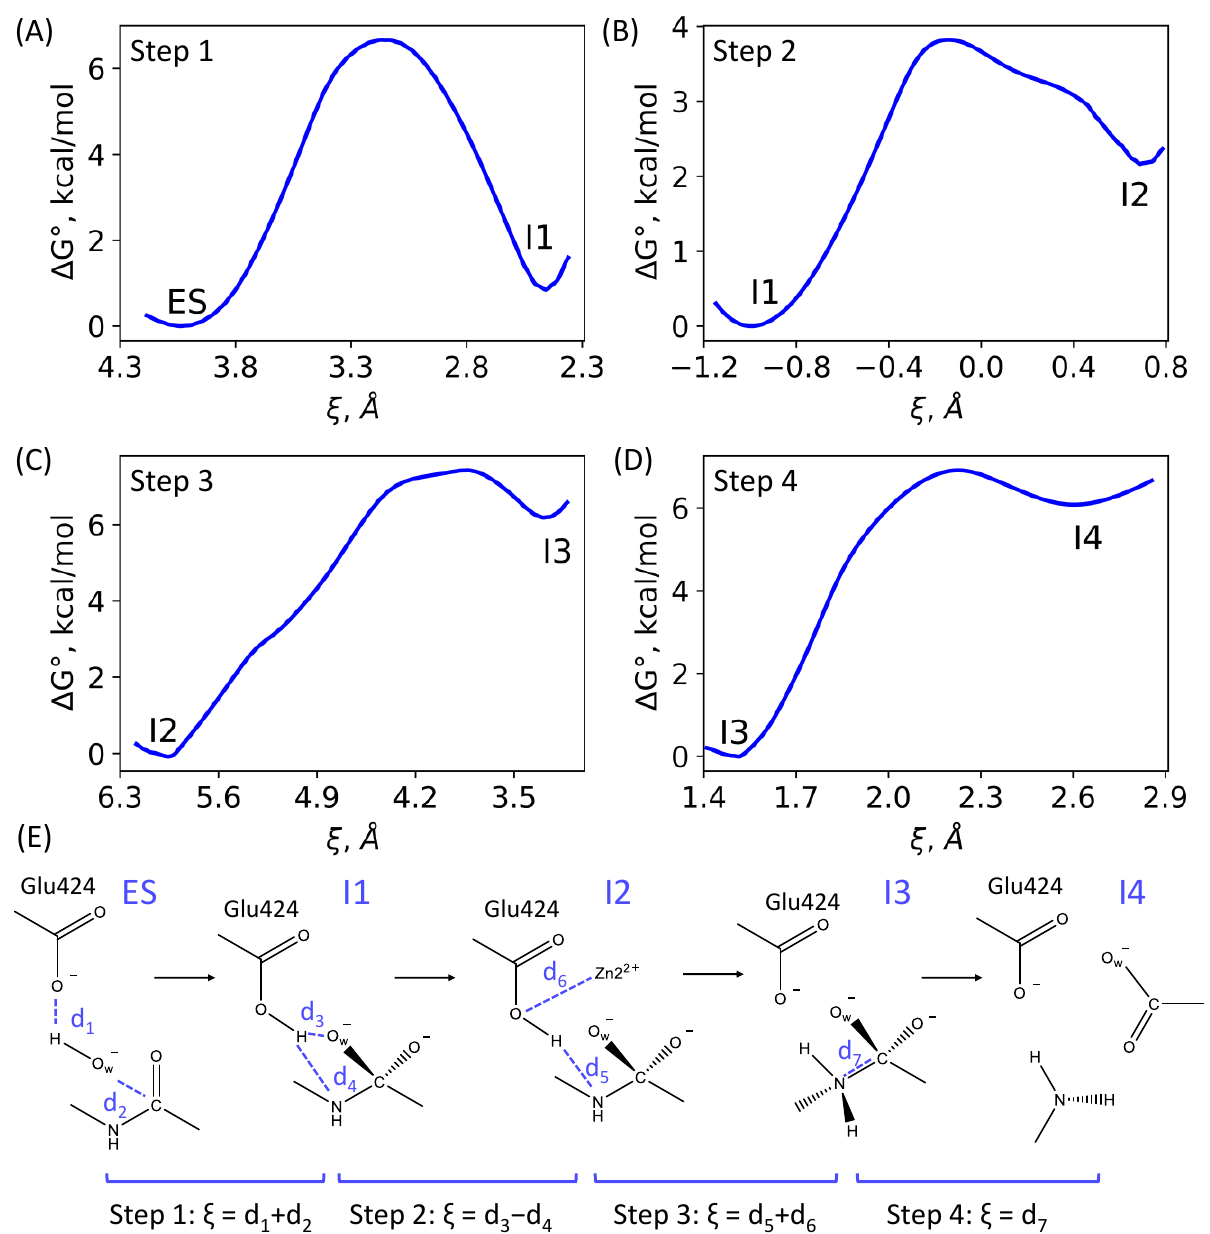
Figure 4. ( A – D ) The Gibbs energy profiles of the elementary steps of NAAG hydrolysis in the active site of the wild type GCPII. ( E ) Rearrangements in the active site during each step and reaction coordinates, ξ , utilized in umbrella sampling QM/MM MD simulations.